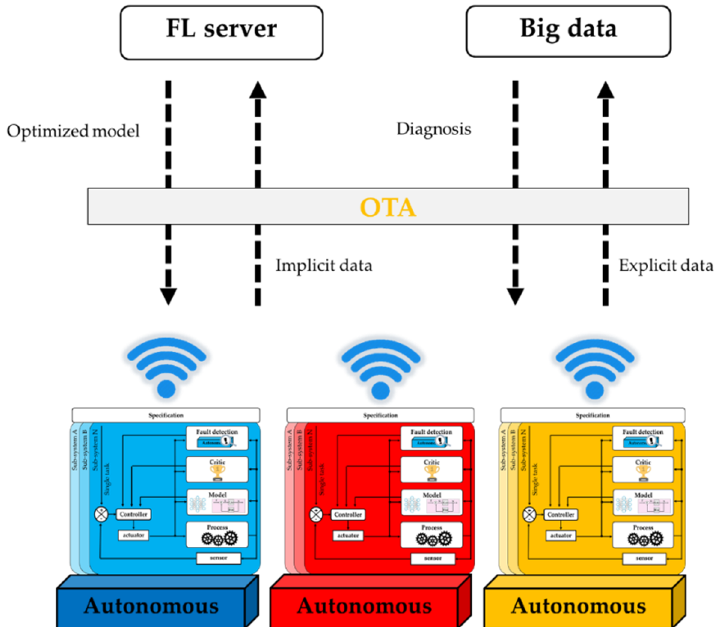
Figure 8. Integration of autonomous systems.